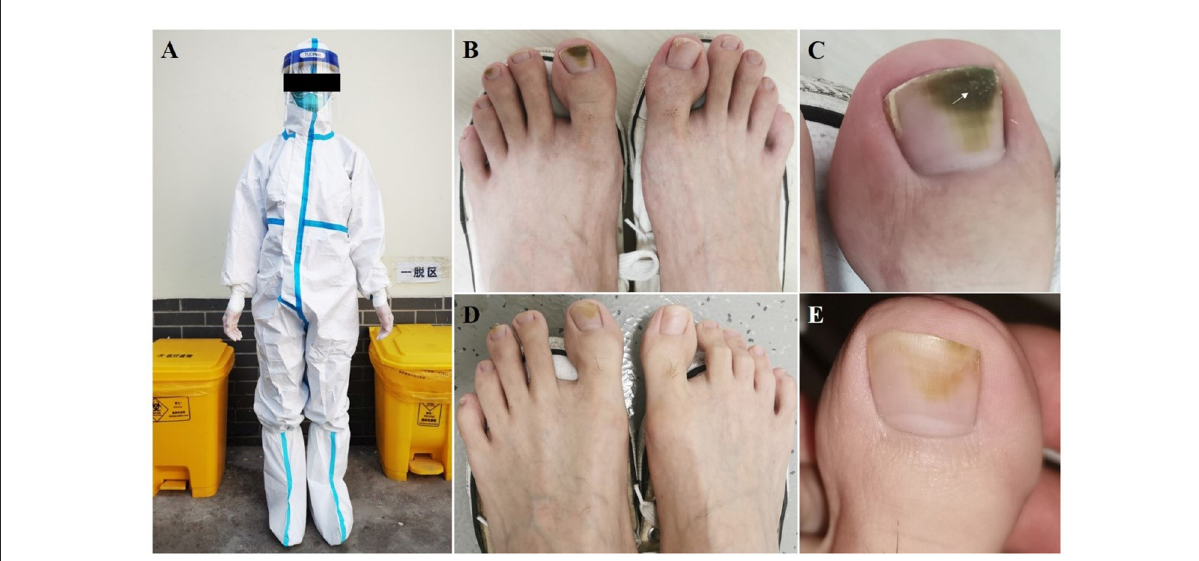
FIGURE1 Clinical Images. (A) Epidemic prevention volunteer wearing personal protective equipment. (B,C) Greenish black discoloration of the middle and distal parts of the first and third toenails on the left foot; white scale (white arrow) on the distal part of the big toenail plate. (D,E) At the 2-month follow-up, the greenish discoloration had faded